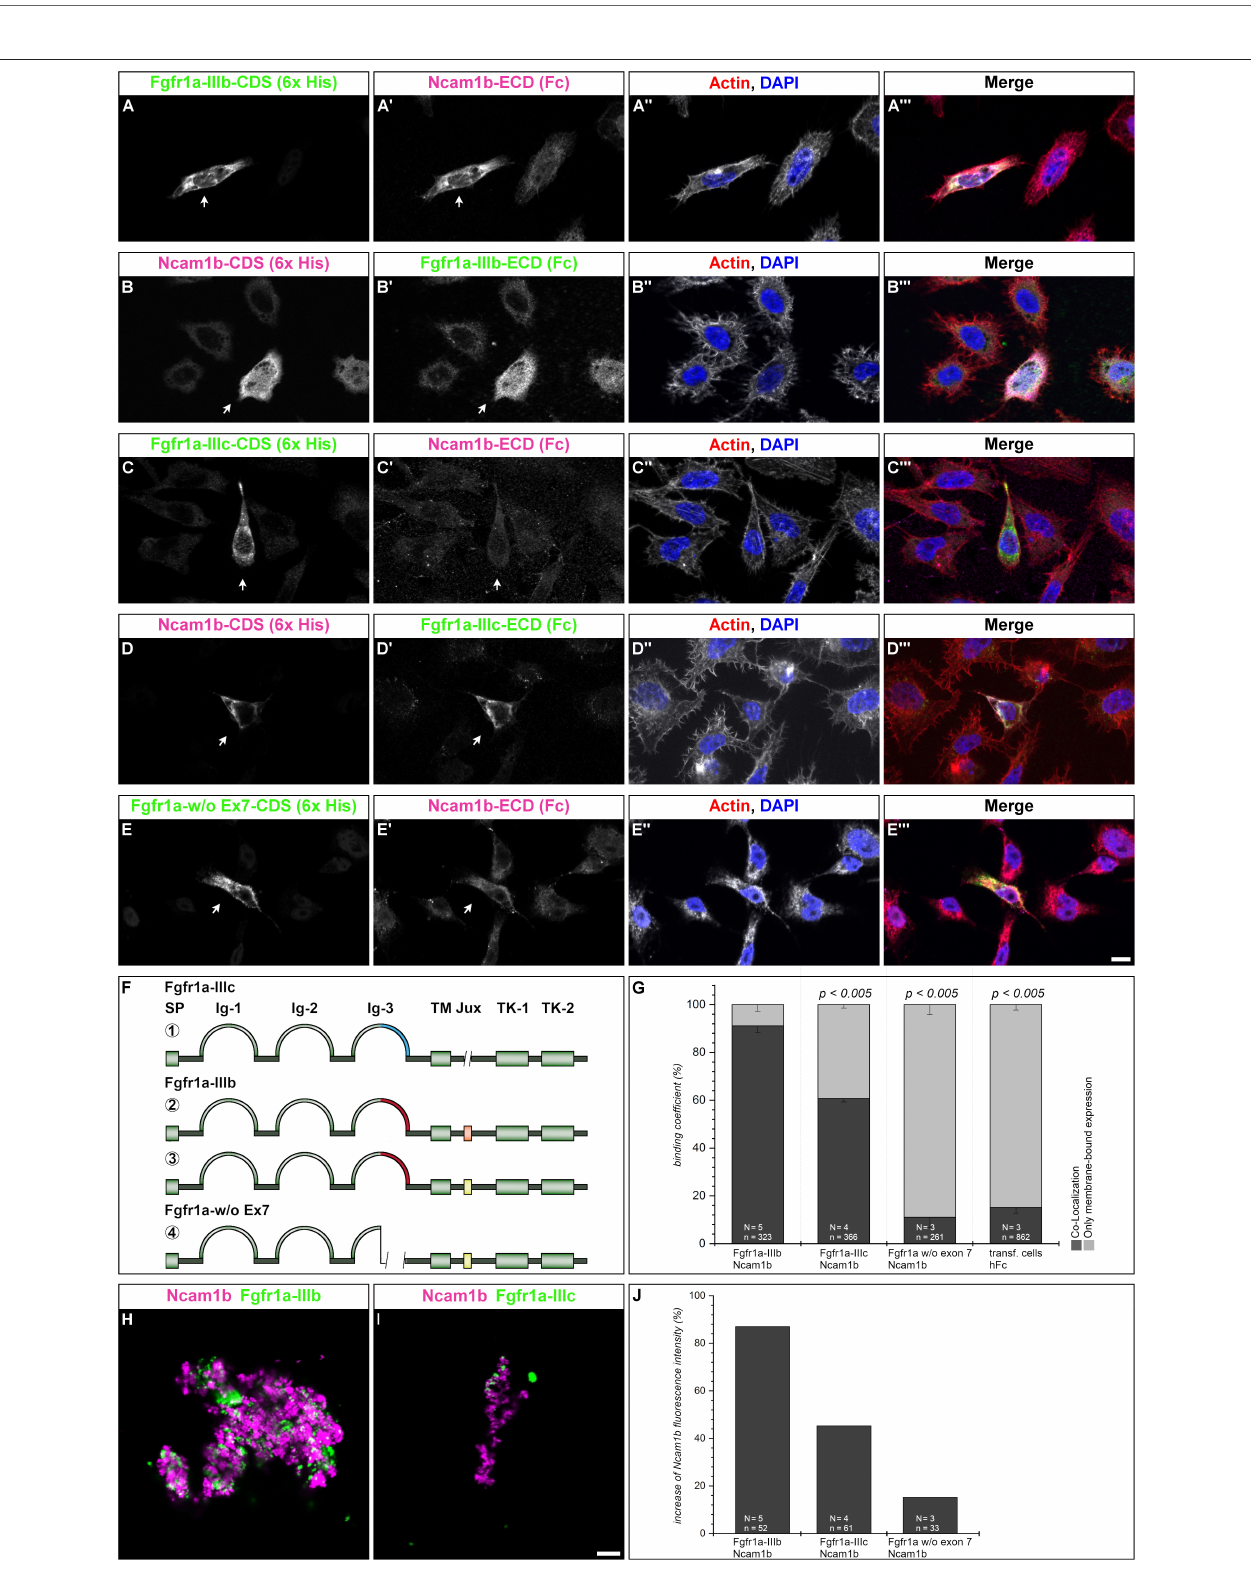
FIGURE 4 | Ncam1b interactions with different isoforms of Fgfr1a. CHO-K1 cells were transfected with complete coding sequences (CDS) of one of three Fgfr1a-isoforms (green; IIIb, IIIIc, or w/o Ex7) or of Ncam1b (magenta). Transfected cells were incubated for 1 hr with either soluble Ncam1b or one of the two